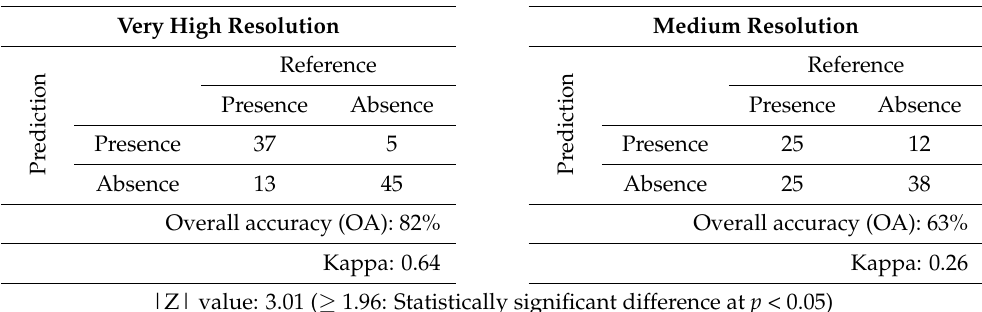
Table 6. Area (ha) modeled for tall tree (Cuban cedar), medium tree (guava), and shrub (blackberry) growth forms, using very-high-resolution (VHR) and medium-resolution (MR) satellite imagery. Tall Tree Medium Tree Shrub (Cuban Cedar ) ( Guava ) ( Blackberry